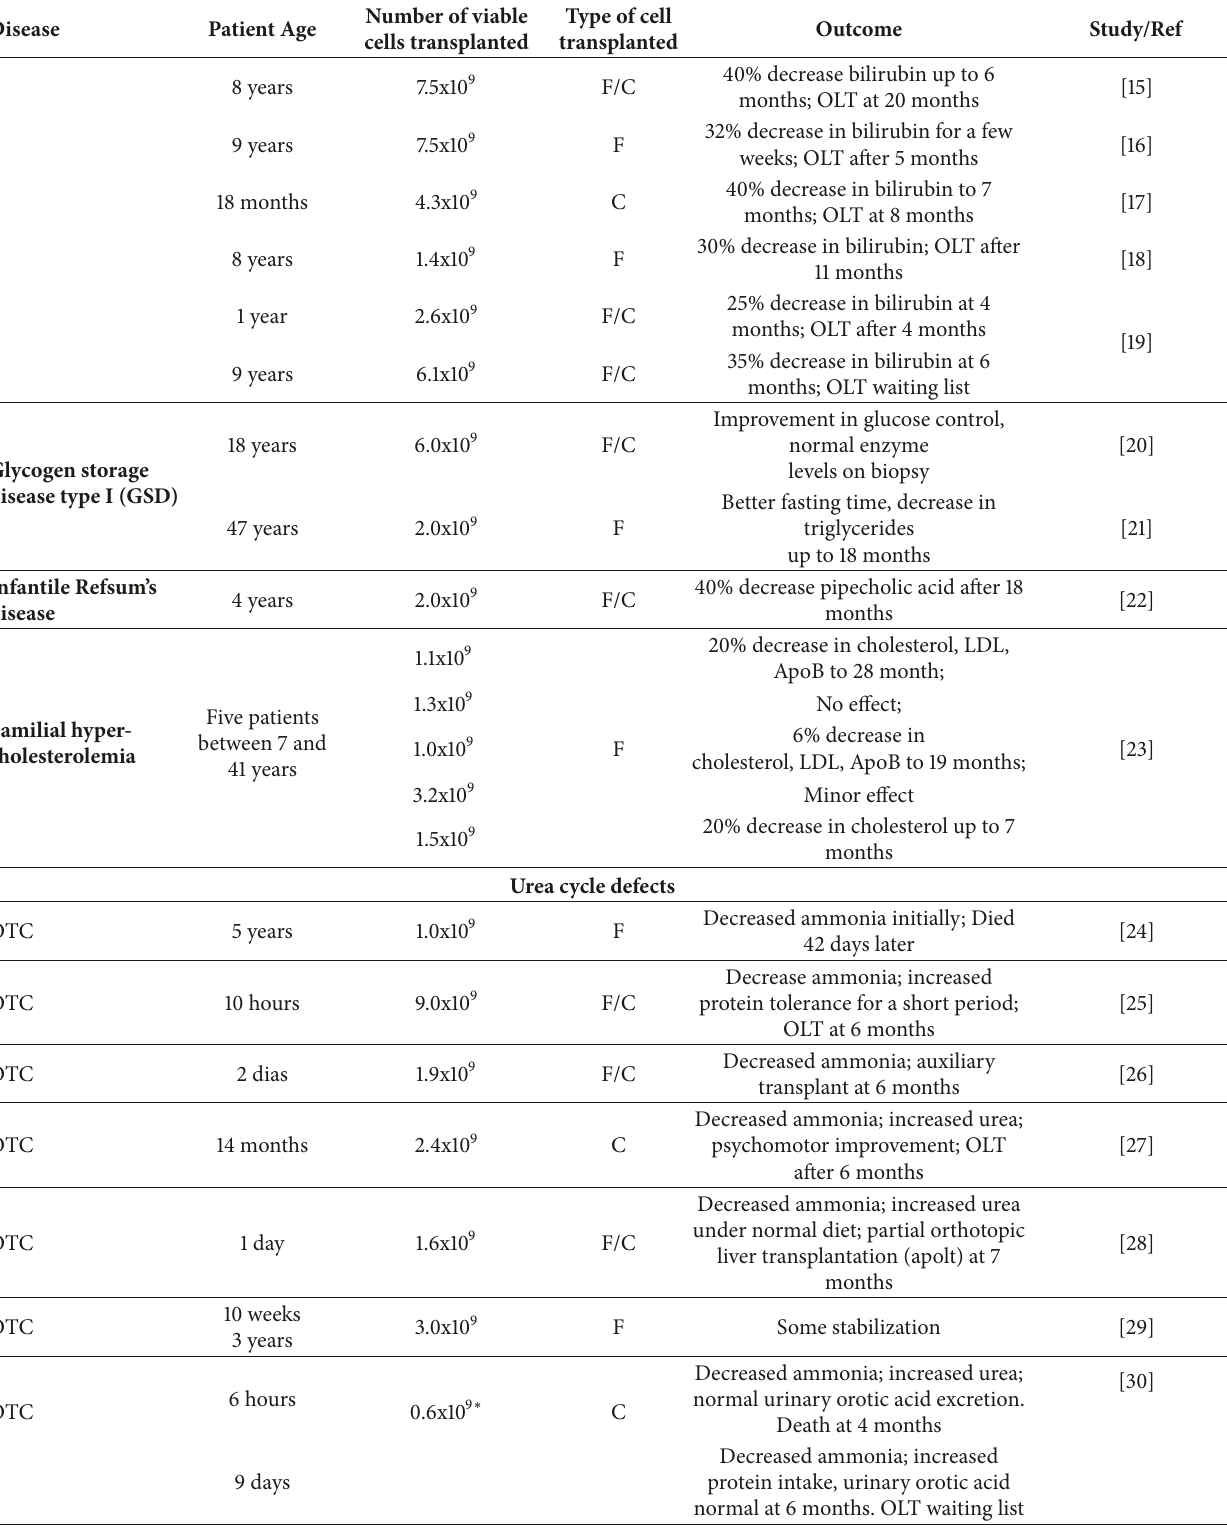
Table 1: Human hepatocyte transplantation: clinical studies in patients with metabolic liver disease.